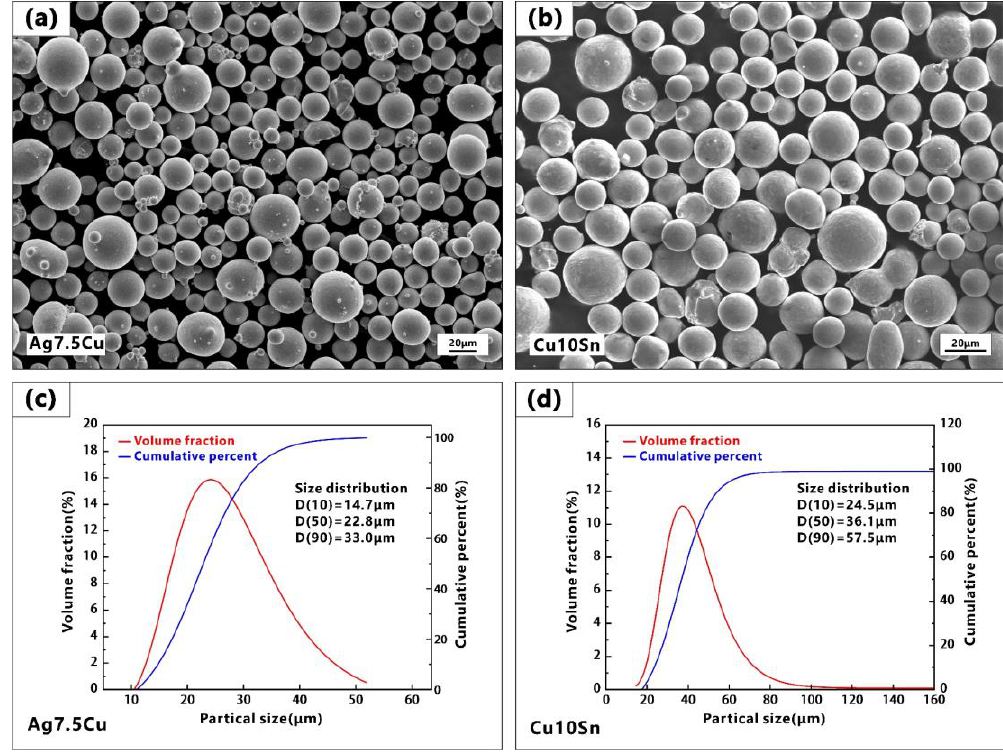
Figure 1. ( a , b ) SEM images of Ag7.5Cu and Cu10Sn powders, respectively; particle size distribution of ( c ) Ag7.5Cu powders and ( d ) Cu10Sn powders.